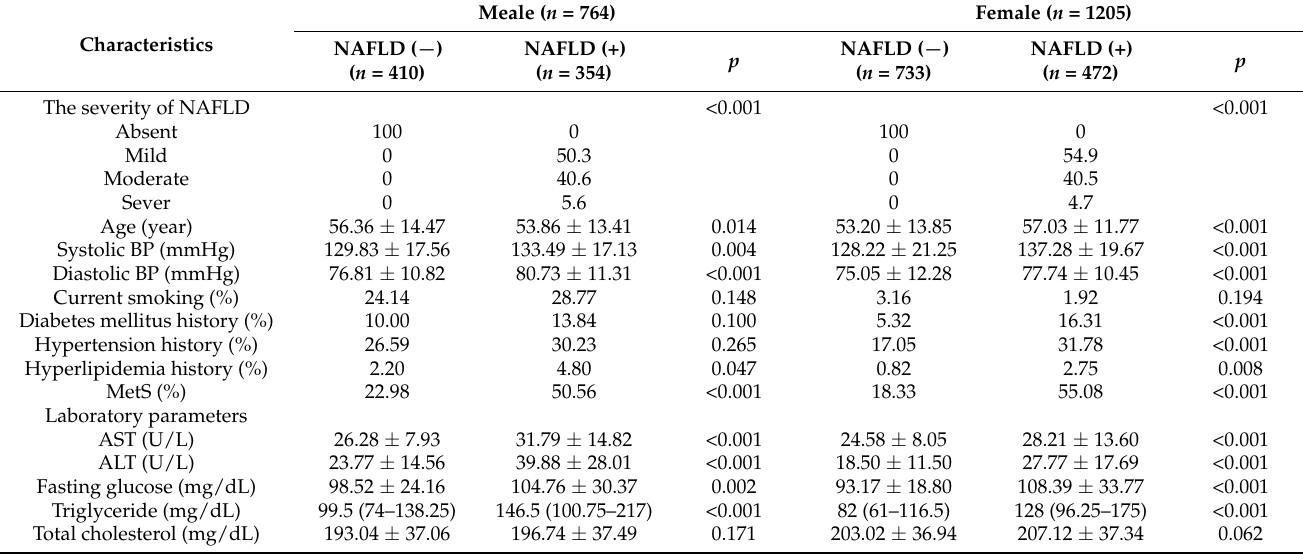
Table 1. Clinical characteristics of the study participants classified by the presence of different gender and Nonalcoholic fatty liver disease